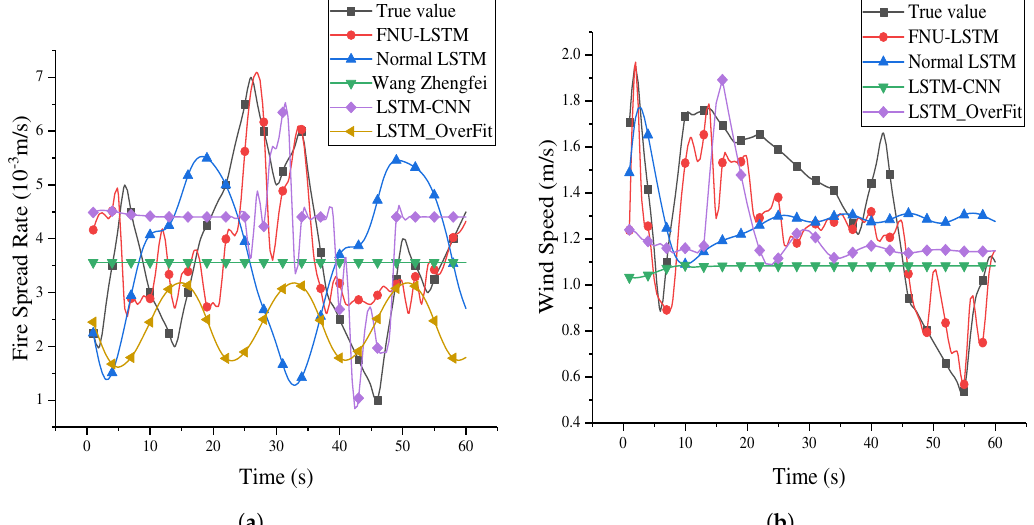
Figure 12. The scatterplot of neural network model prediction error and centroid distribution. ( a ) The fire spread rate prediction and true value. ( b ) The wind speed prediction and true